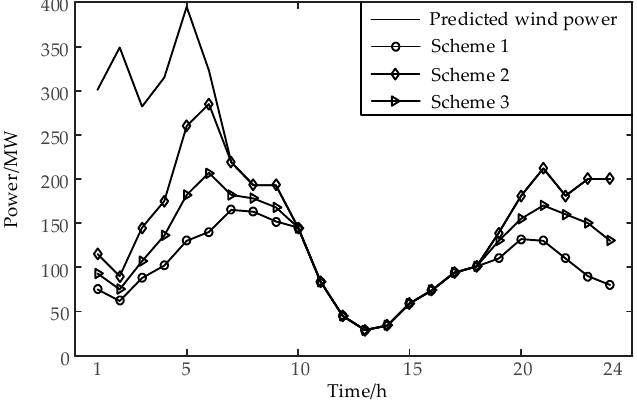
Figure 5. Wind power consumption of three schemes. 371